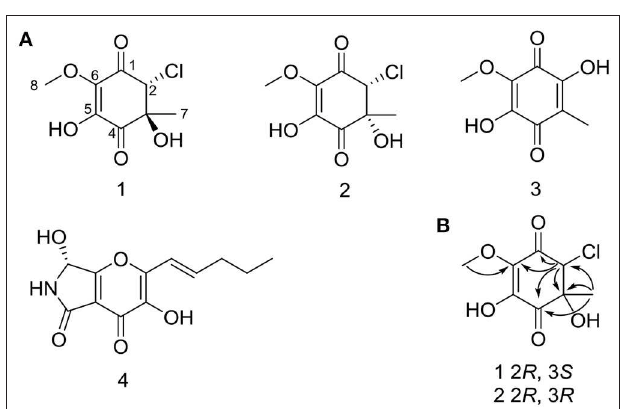
FIGURE 2 | (A) Structures of 1 – 4 from mutant strain OE::PbrLaeA P. brocae HDN-12-143. (B) Key HMBC correlations of 1 and 2 .